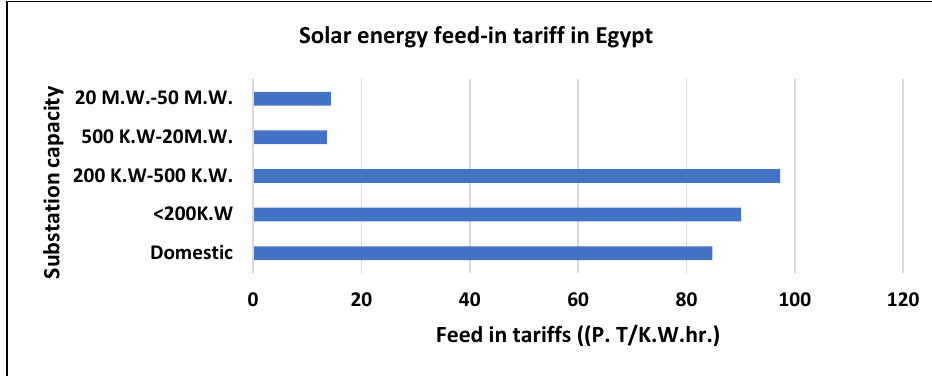
Figure 8. Feed-in tariff values for solar energy resources in Egypt.